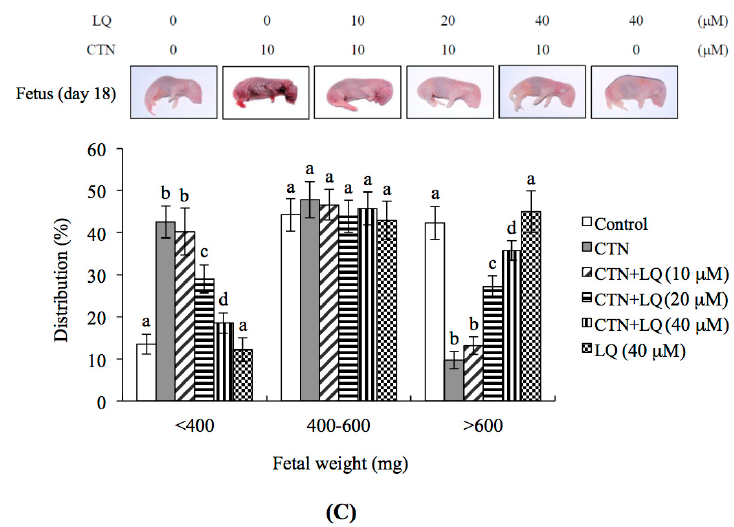
Figure 3. Effects of LQ on implantation, resorption, fetal survival and fetal weight in CTN-treated blastocysts via embryo transfer assay. ( A ) Mouse blastocysts were preincubated with LQ (10–40 μ M). After 1 h, embryos were further treated with or without 10 μ M CTN for another 24 h. Medium containing 0.5% DMSO was used as the control (vehicle group). Embryos were further transferred to pseudopregnant recipient mice. The percentages of implantations, resorptions and surviving fetuses represent the number of implantations, resorptions and surviving fetuses per number of transferred embryos × 100, respectively; ( B ) Placental weights of 40 pseudopregnant recipient mice were examined; ( C ) The weight distribution of each group of surviving fetuses on day 13 post-transfer (day 18 post-coitus) was measured as described in Materials and Methods (320 total blastocyst transfer to 40 recipients). Different symbols indicate significant differences at p < 0.05.